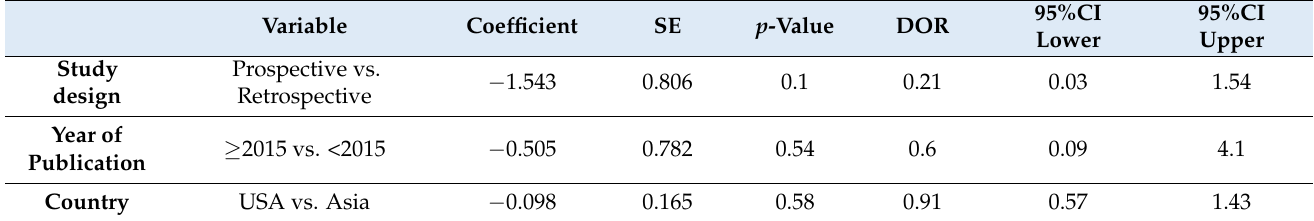
Table 4. Meta-regression analysis of parameters influencing extrathyroidal extension detection accuracy on